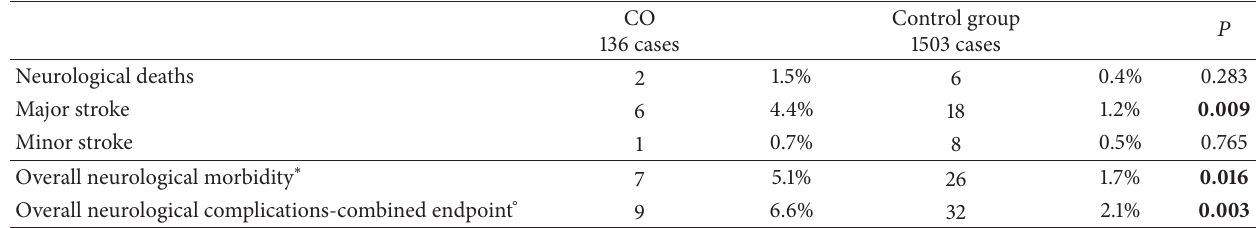
Table 2: Perioperative (30-day) neurological outcomes in 1639 primary carotid revascularizations.